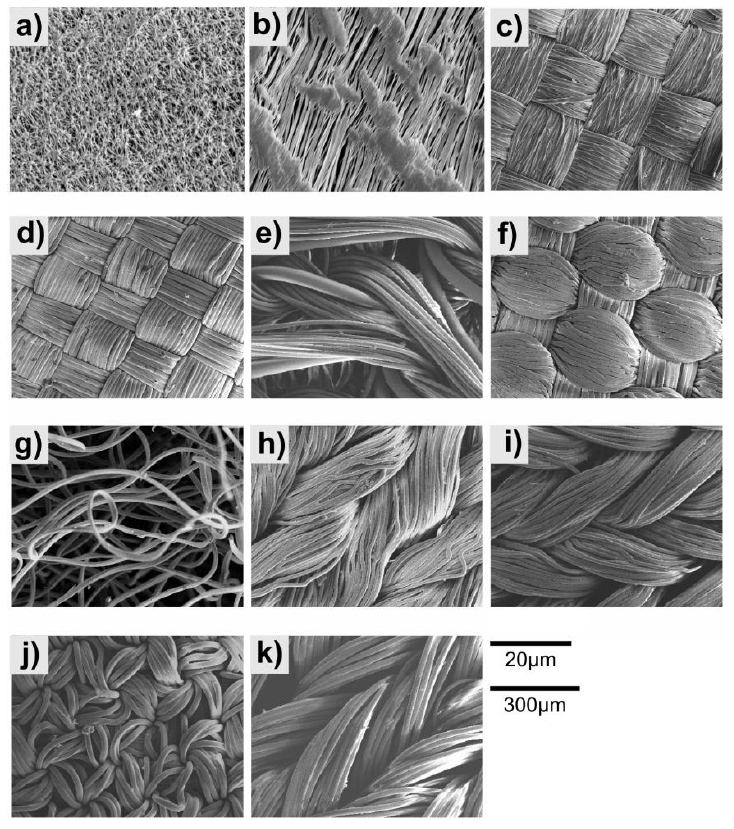
Figure 3. SEM images at 2000× magnification of ( a ) Gore-Tex; and ( b ) PTFE Tape. SEM images at 150× magnification of ( c ) Furtech Polyester; ( d ) Toray Nylon; ( e ) Deep Pile Polyester Reverse; ( f ) Toray Polyester; ( g ) Deep Pile Polyester; ( h ) Speedo Fastskin ® ; ( i ) Speedo Aquablade ® ; ( j ) Speedo LZR Pulse ® ; and ( k ) Speedo Endurance ® . The 20 μm scale bar is for images ( a ) and ( b ). The 300 μm scale bar is for images ( c